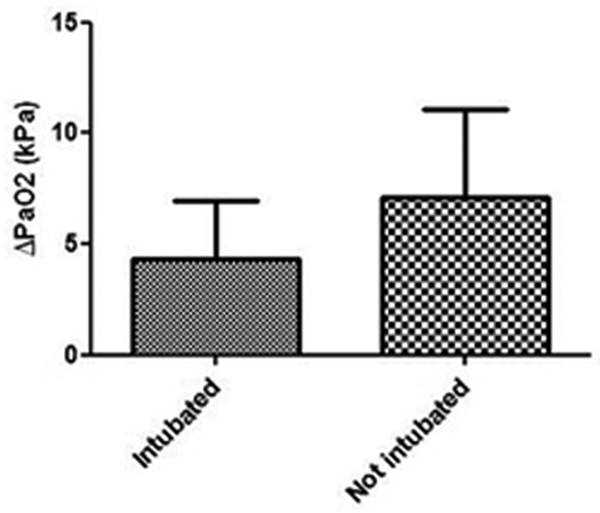
PaO2 after 1-hour HNF therapy.